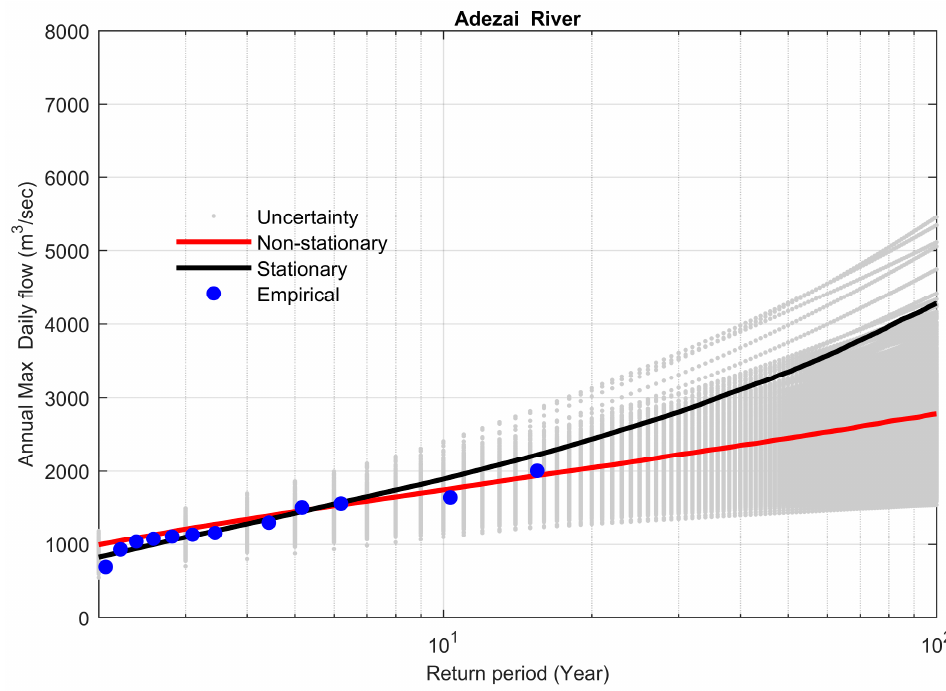
Figure 3. Comparison between non-stationary and stationary flood frequency curves (FFCs) at site 5, along with non-stationary uncertainty bounds for the year 2016.